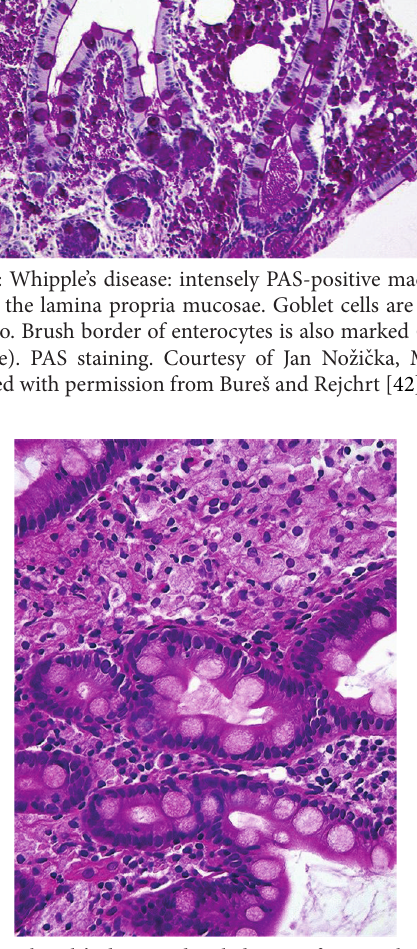
Figure 15: Whipple’s disease: detailed view of macrophages in the lamina propria mucosae. Hematoxylin-eosin staining. Courtesy of Jan Noˇziˇcka, MD, PhD. Reproduced with permission from Bureˇs and Rejchrt